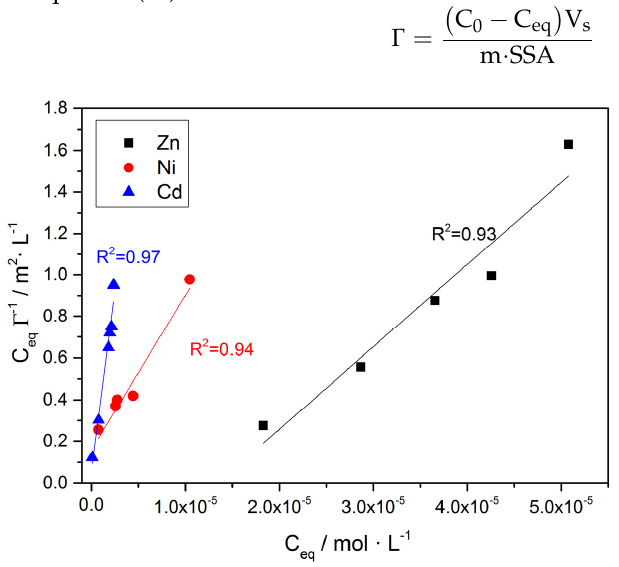
Figure 16. Fitting of the uptake of Zn, Ni and Cd on calcite in the linearized Langmuir adsorption isotherm (Equation (10)); pH 8.5, 25 °C, 0.15 M of NaC1.